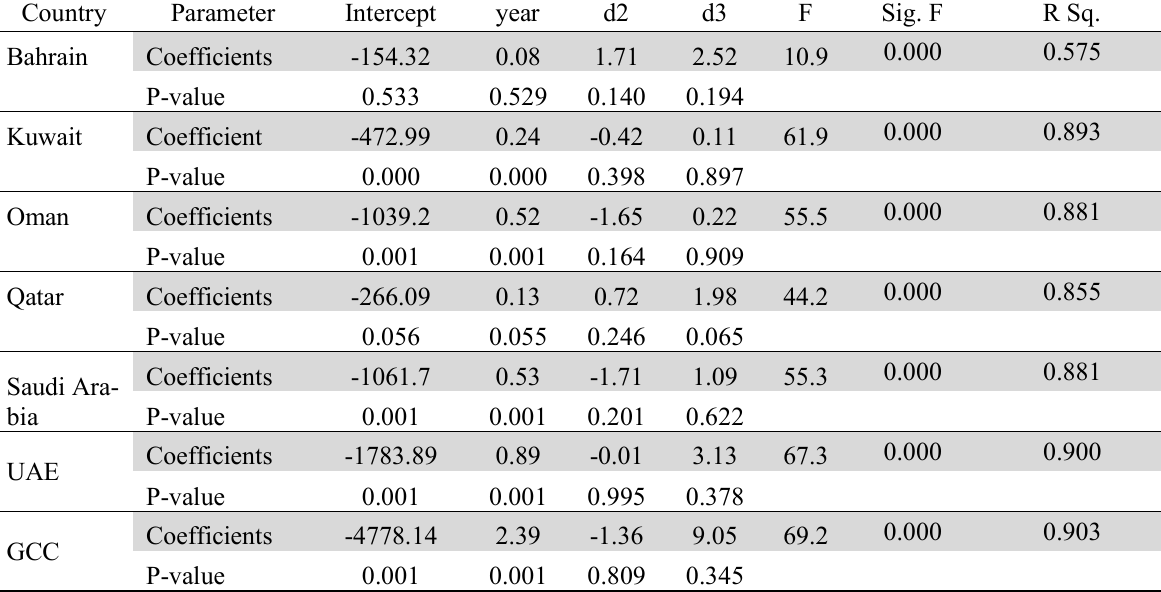
The Results of Trend Regression Analysis of GCC Intra-Trade